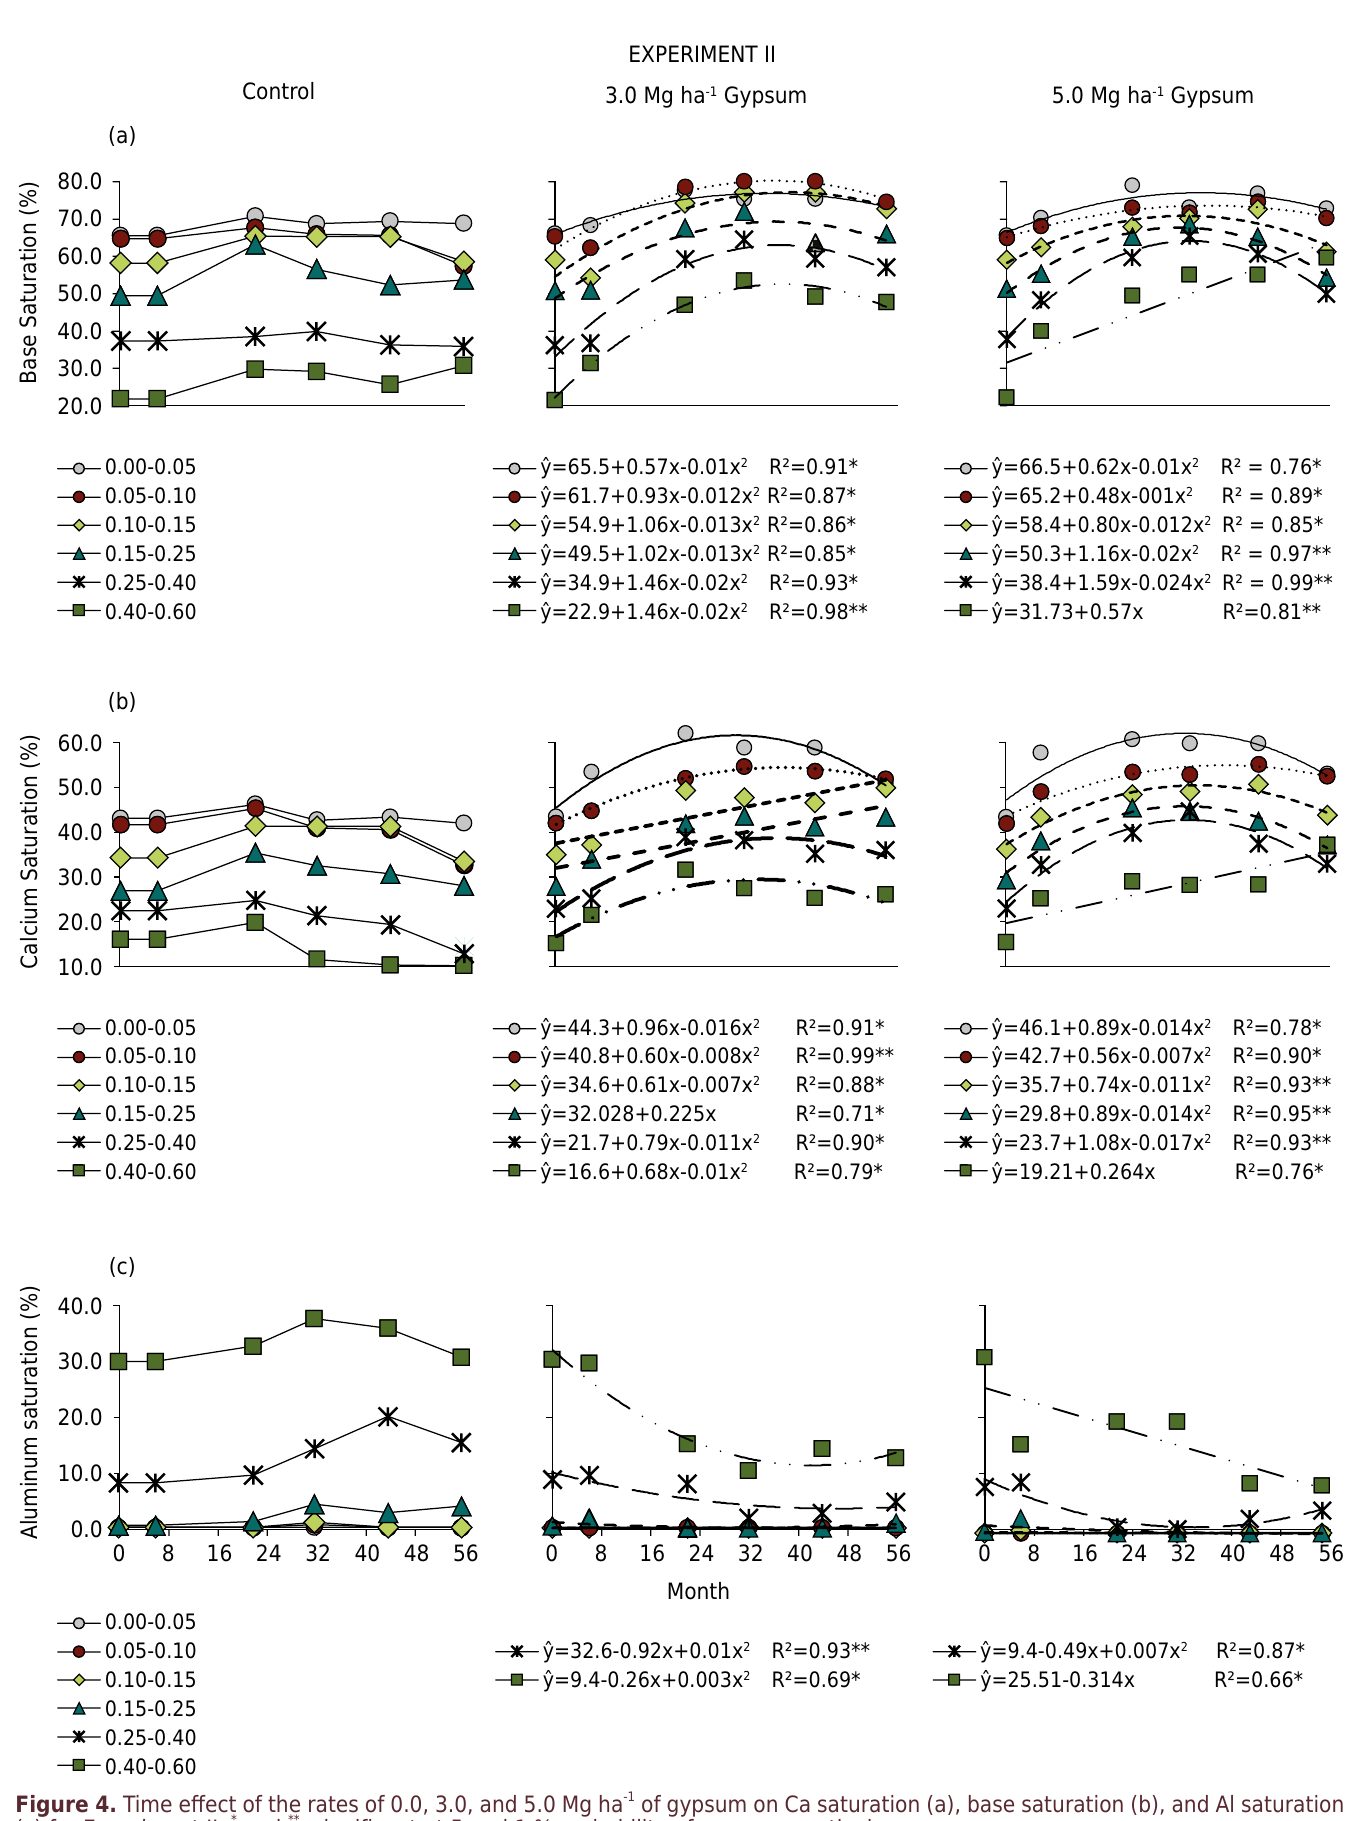
Figure 4. Time effect of the rates of 0.0, 3.0, and 5.0 Mg ha -1 of gypsum on Ca saturation (a), base saturation (b), and Al saturation (c) for Experiment II. * and ** : significant at 5 and 1 % probability of error,